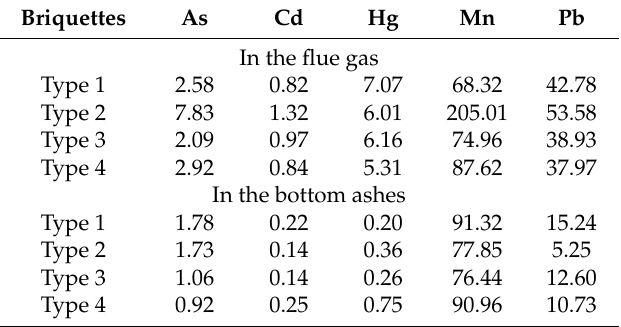
Table 3. Heavy metals contained in the flue gas and in the bottom ashes in mg metal /kg fuel . Briquettes